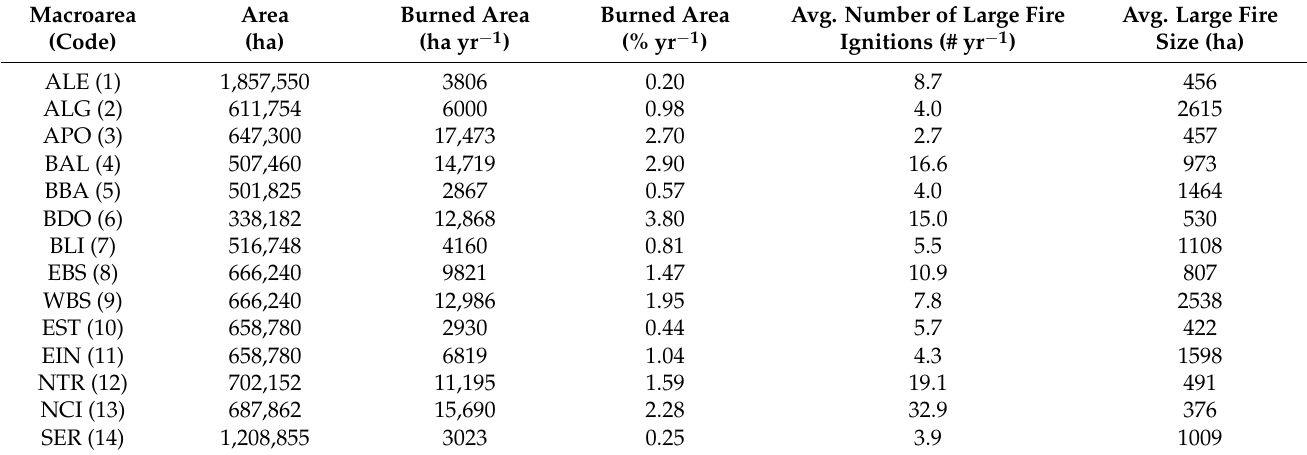
Table 2. Historic wildfire activity within the different macro-areas of Portugal (Figure 1) from 1985 to 2019. We considered a 100-ha large fire threshold to describe the fire activity in the different macro-areas. See macro-area abbreviations in Table 1. We used the annually burned area to determine the number of fire ignitions required to replicate a burned area equivalent to 10,000 years per